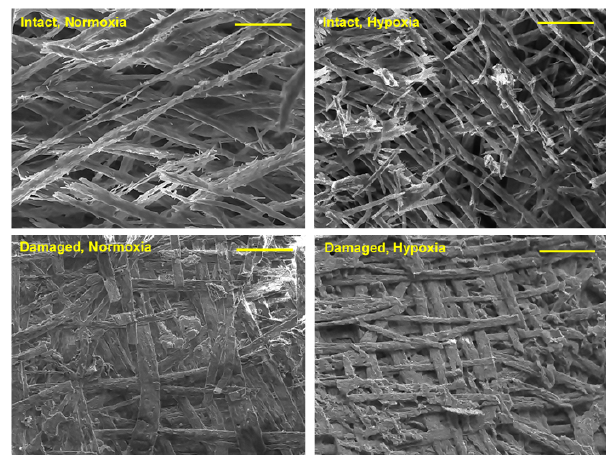
Figure 6. SEM images of the inner surface of H. diramphus shells produced in different treatments, indicating the shell integrity. The carbonate crystals of newly produced shells appear to be thicker and more compact following non-lethal shell damage, regardless of the dissolved oxygen level. Scale bar: